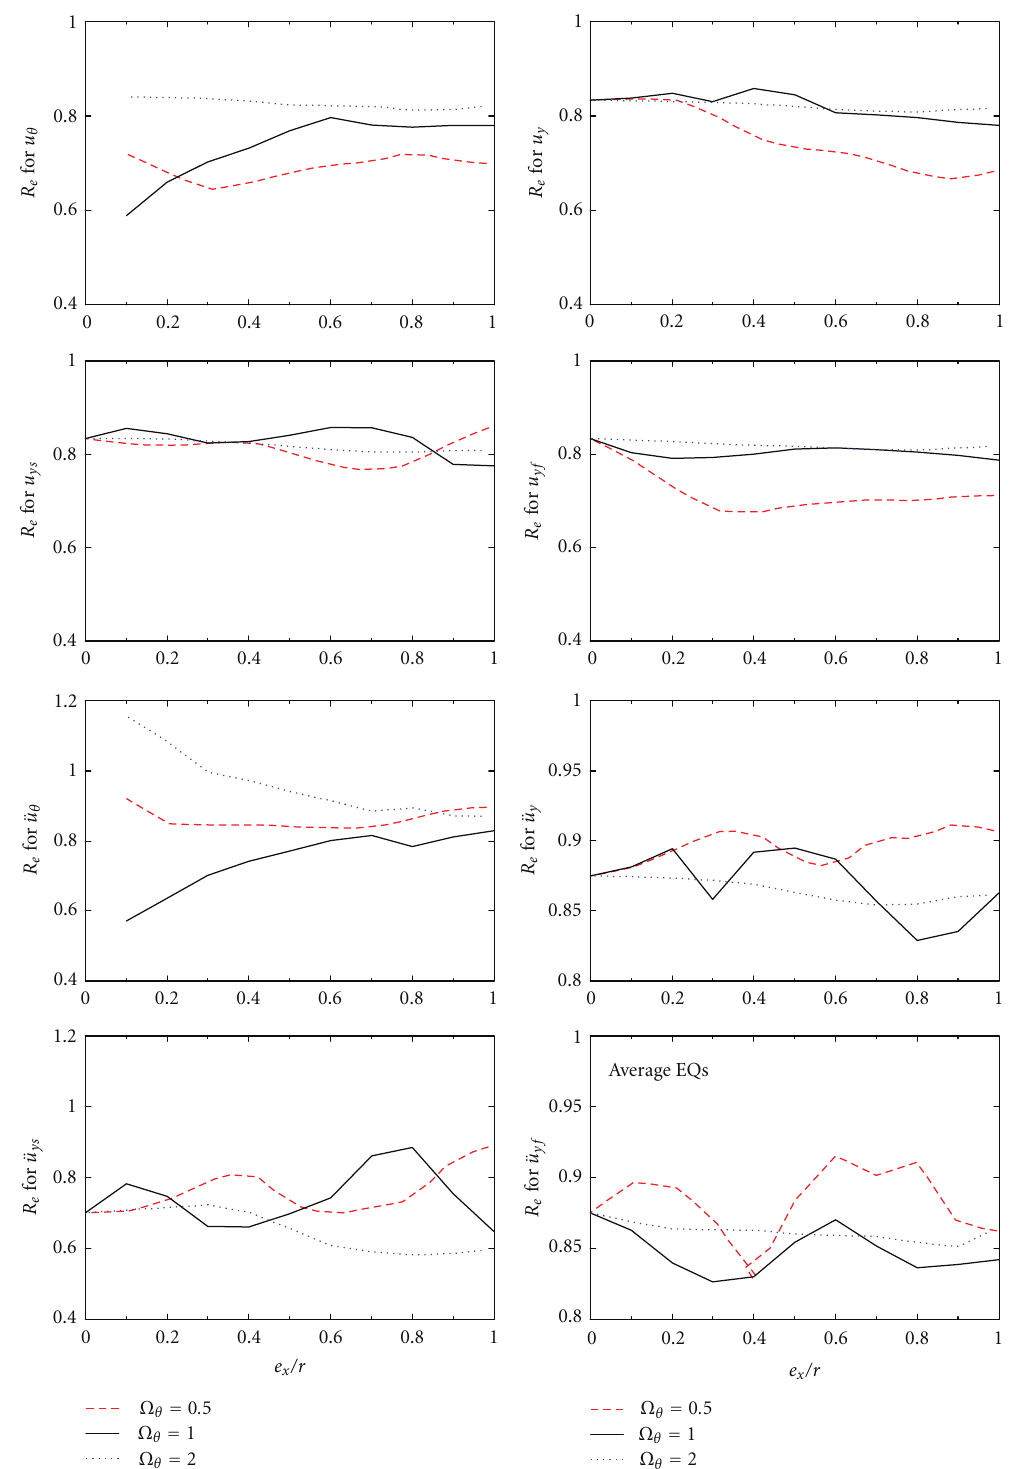
Figure 20: E ff ect of eccentricity on response ratio, R e for various peak response quantities under average earthquakes ( T y = 1). clipped-optimal control algorithm with parametric varia- control system for asymmetric systems. The important tions to study the e ff ectiveness of semiactive control sys- parameters considered are: eccentricity ratio of superstruc- tem for torsionally coupled system and the influence of ture, uncoupled lateral time period, and ratio of uncoupled important parameters on the e ff ectiveness of semiactive torsional to lateral frequency. From the trend of the